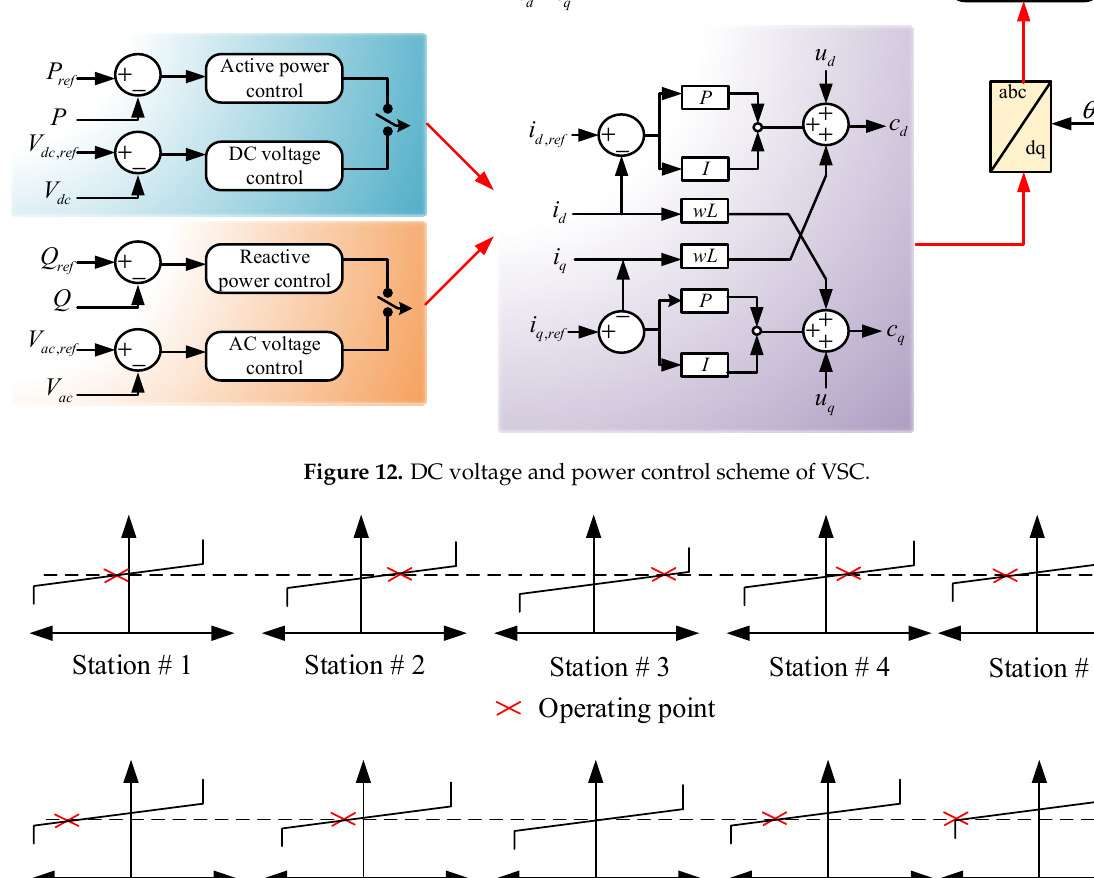
Table 4. Multi-terminal HVDC systems throughout the arena.